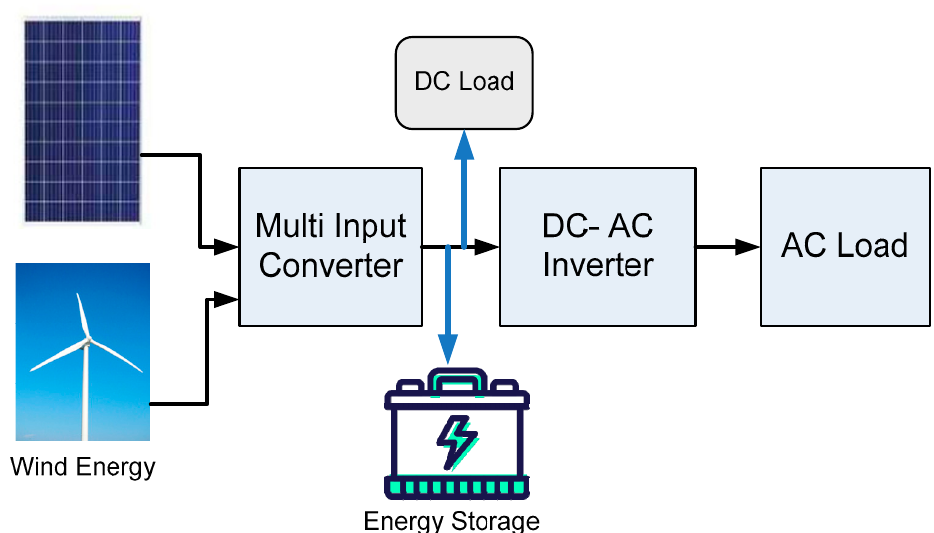
Figure 1. Block diagram of MIMO converter in energy storage.